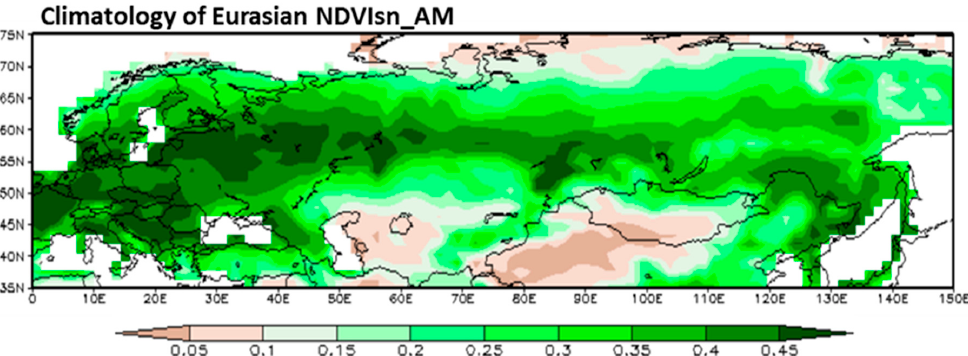
Figure 1. Spatial distributions of the 34-year (1982–2015) spring (April–May, AM) NDVIsn climatology over Eurasia. The color scale changes from brown to green. The greener color represents the regions with higher NDVI values and corresponds to the locations with denser and greener vegetation. The brown color represents the regions with little or no vegetation.